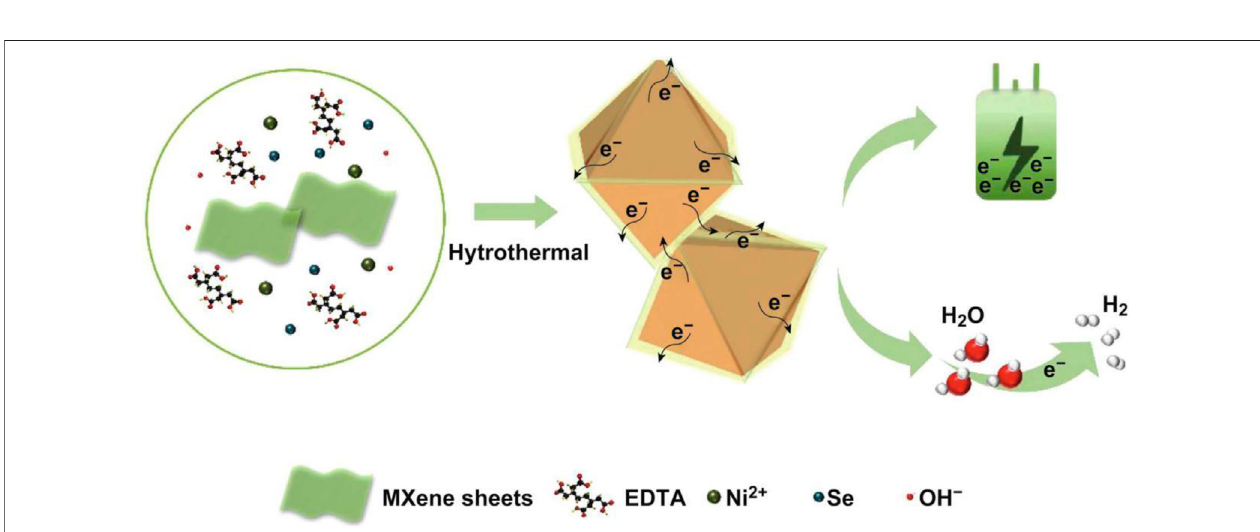
FIGURE 21 | Schematic illustration for the formation of octahedral NiSe2/Ti3C2Tx hybrid through one-pot hydrothermal method.